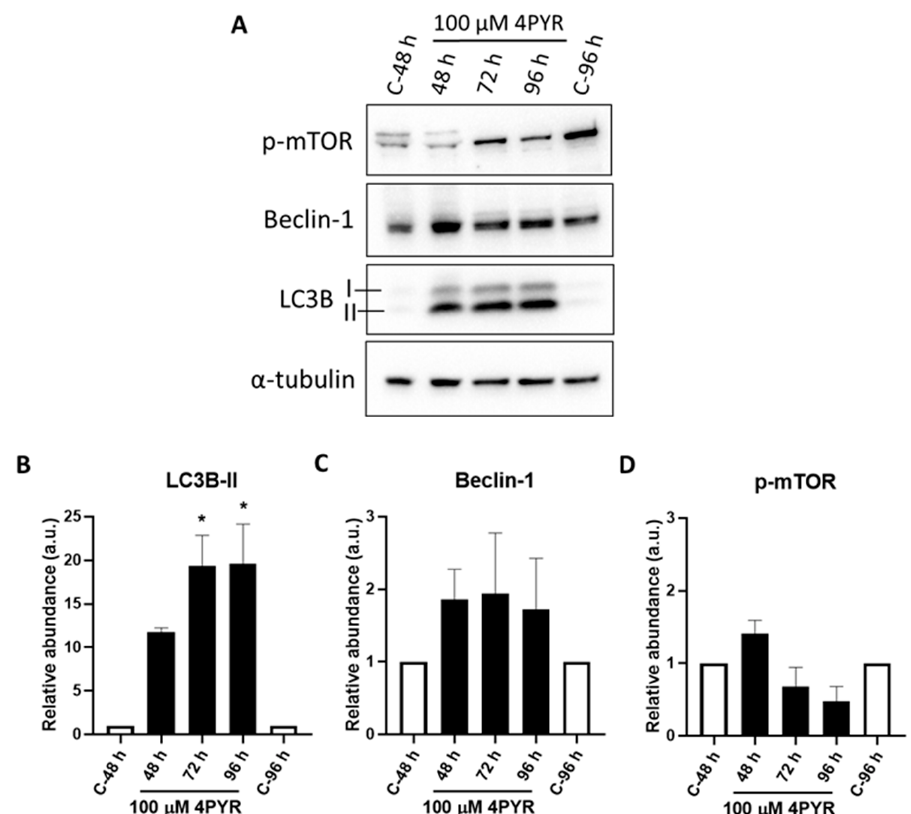
Figure 7. 4PYR induced autophagy in HepG3 cells. HepG3 cells were continuously dosed with 100 µM of 4PYR for 48, 72, and 96 h. ( A ) Increased protein expression levels of the autophagy marker LC3BII, Beclin-1, and decrease in phospho-mTOR were assessed using immunoblot in 4PYR treated HepG3 cells compared to vehicle-treated control cells. α -tubulin was used as a loading control for immunoblotting. The graph shows quantified protein expression levels relative to controls for ( B ) LC3B-II, ( C ) Beclin-1 and ( D ) phosphor-mTOR in HepG3 cells. Results are expressed as relative abundance (a.u.) ± SEM of two biological replicates. Statistical significance: * p < 0.05. Finally, we exposed HEK293T and HepG3 cells to 100 µM NRH, the reduced form of